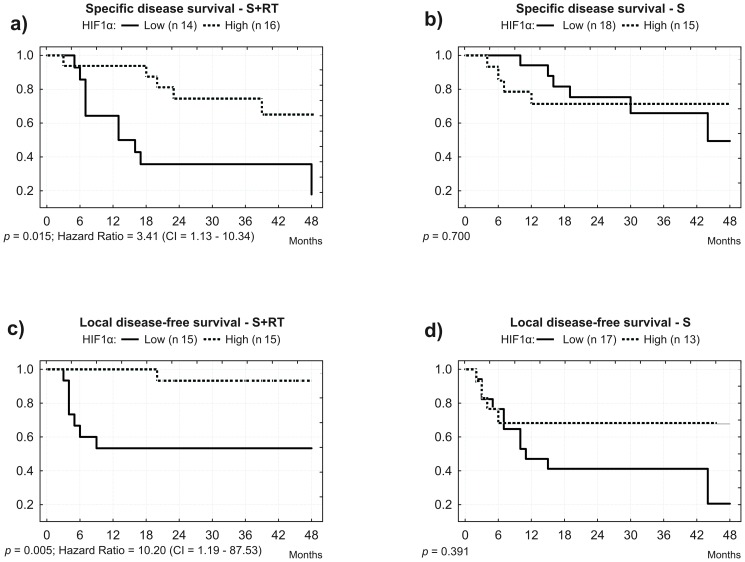
HIF1α expression and specific or local disease-free survival after treatment.Considering surgical (S) treatment only, high HIF1α expression predicts local disease-free survival. Considering surgery plus radiotherapy (S+RT), high HIF1α expression predicts both specific and local disease-free survival.